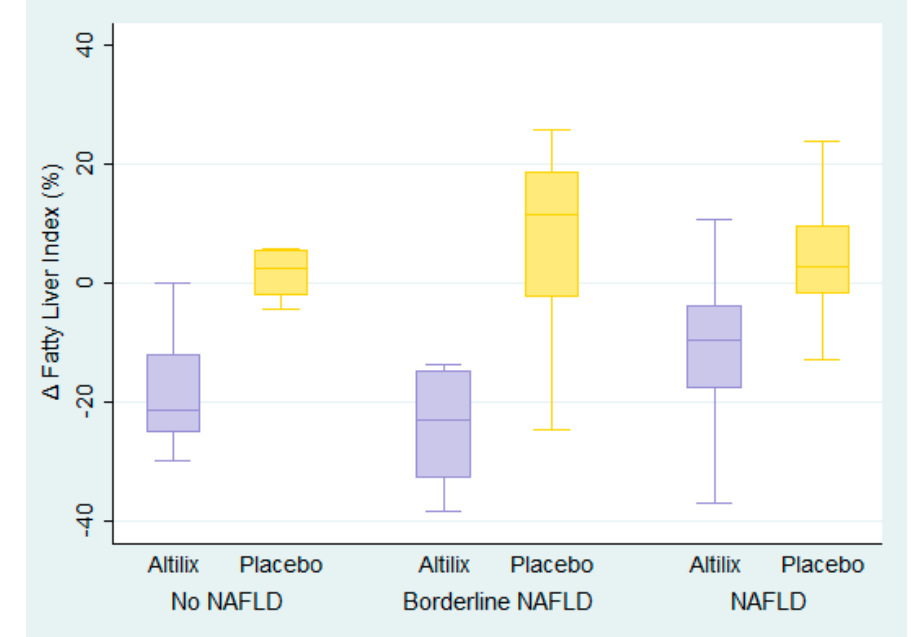
Figure 2. Box plots of fatty liver index (FLI) percentage change at the end of the study in all subjects, according to the baseline presence and degree of NAFLD ( n = 100).